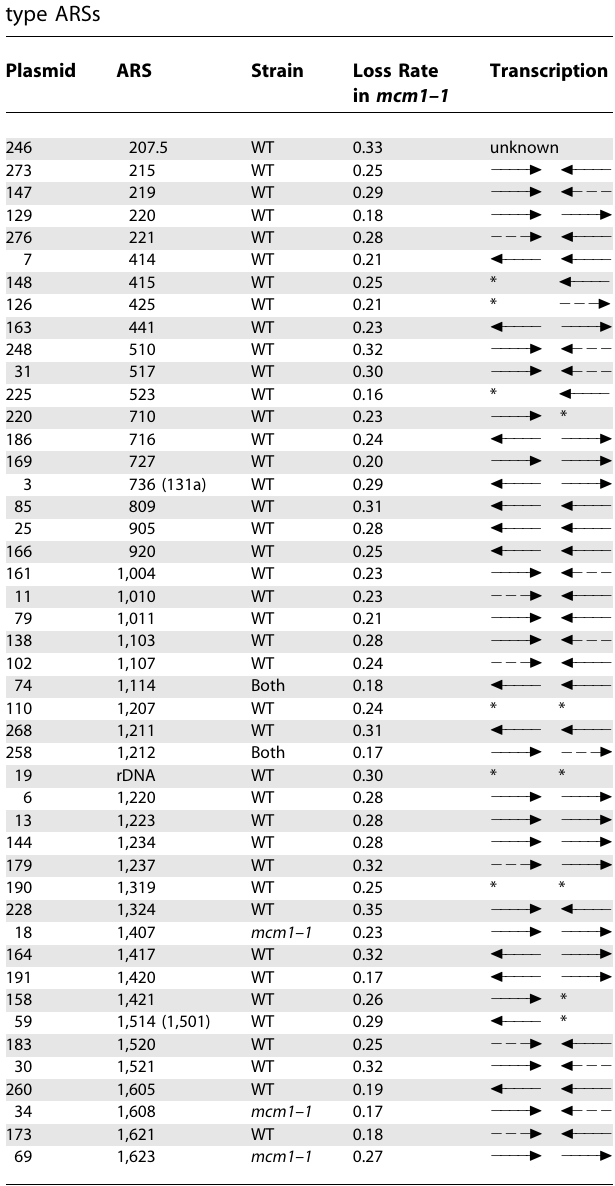
found in Table 3. Here, 32/45 (71%) of B-type ARSs localize in